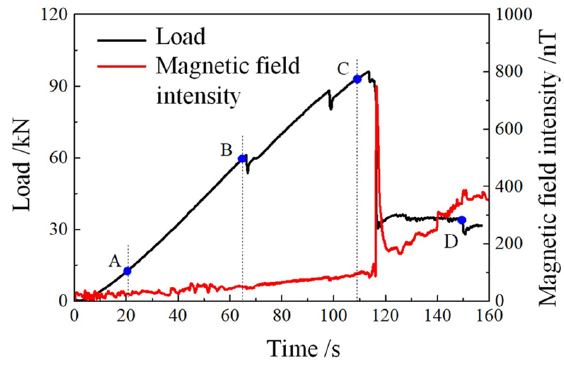
Figure 6. MFI curve of concrete sample.